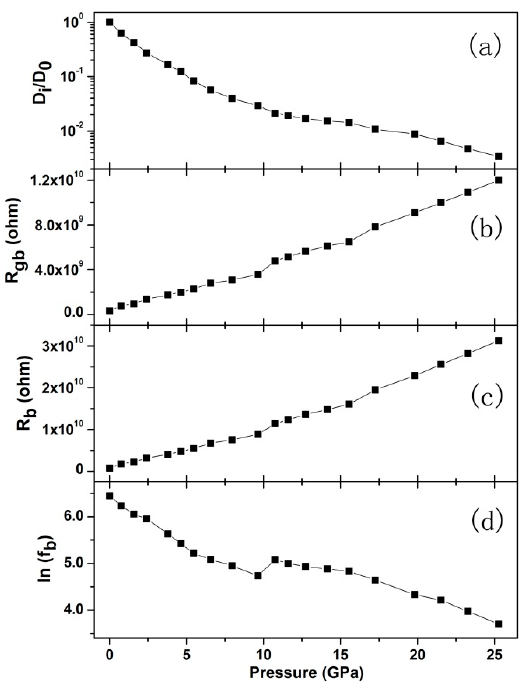
Figure 6. ( a ) the diffusion coefficient, ( b ) the bulk resistance, ( c ) the grain boundary resistance, ( d ) the bulk relaxation frequency under high pressure. D 0 represents the diffusion coefficient at 0 GPa.